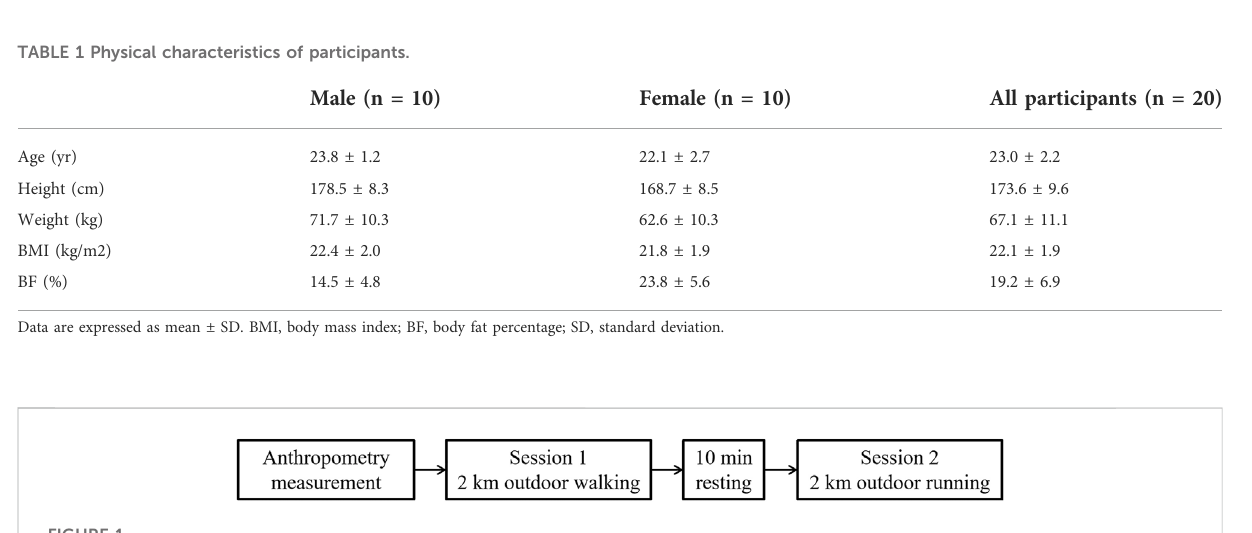
FIGURE 1 Experimental protocol. In the fi rst session, the subjects were advised to walk a 2-km distance at approximately 6 km/h. In the second session, the subjects were asked to run a 2-km distance at approximately 10 km/h. Two sessions were separated by 10 minutes sitting